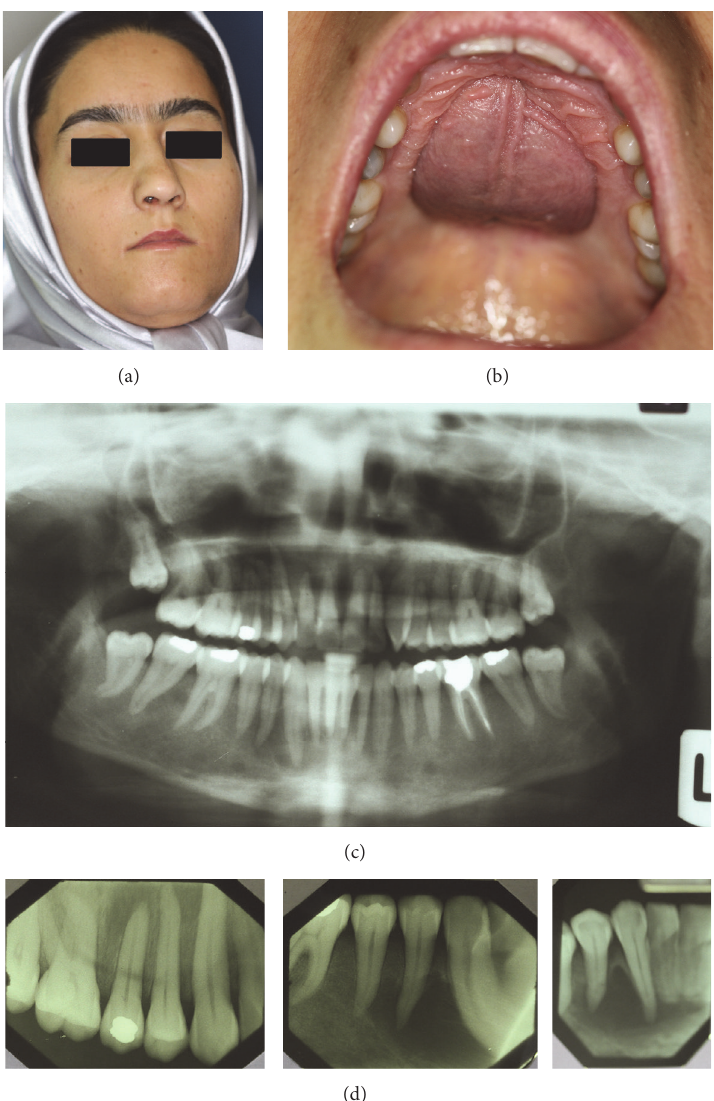
Figure 1: First visit: (a) extraoral frontal photography, (b) intraoral photography, and (c) panoramic and (d) periapical